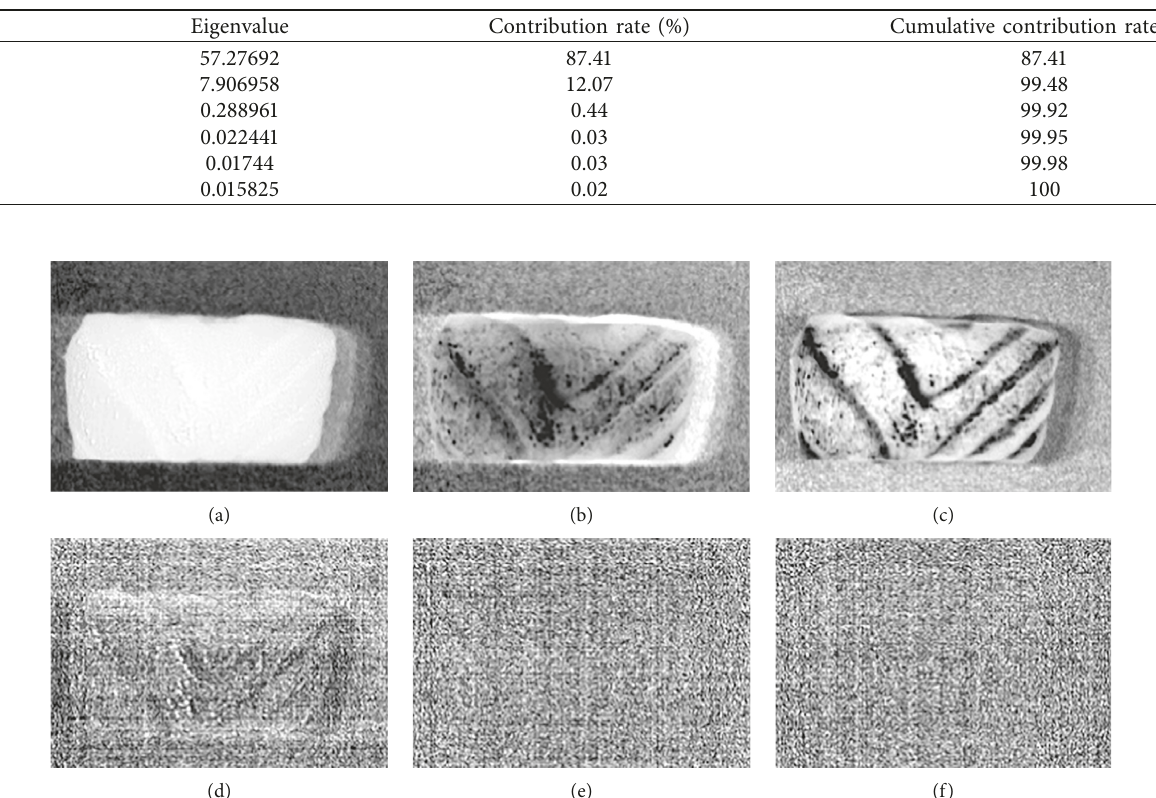
Table 1: Principal-component eigenvalues and contribution rates of the salmon sample containing 0.3mL of water.